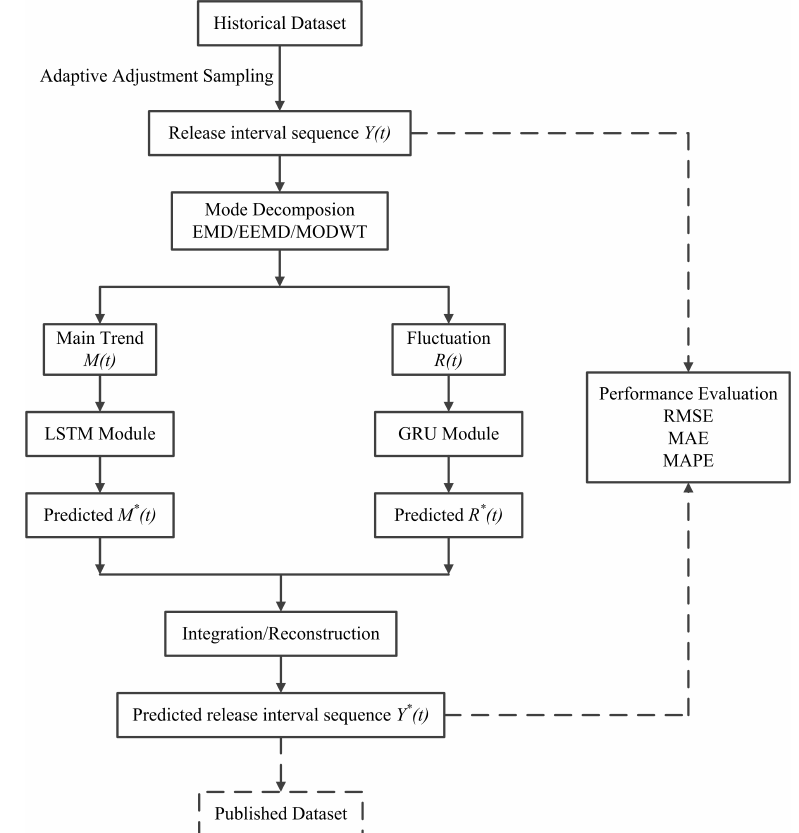
Figure 4. A framework for predicting interval-based publishing of big location data based on deep learning. GRU, Gated Recurrent